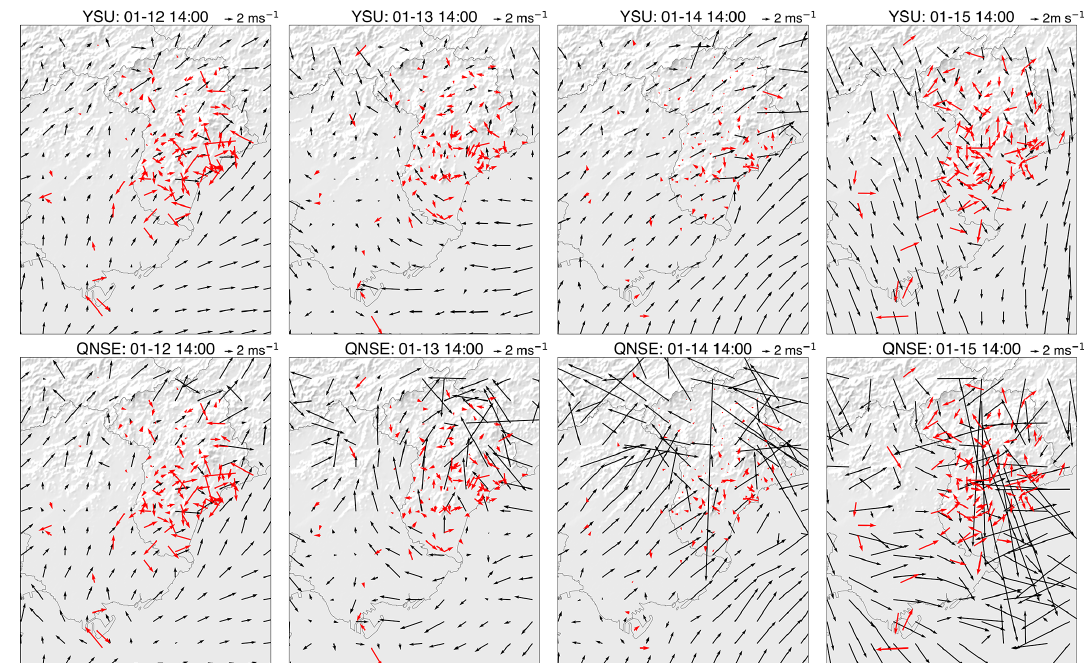
Figure 13. Spatial distribution of simulated (black vector) and observed (red vector) winds at 14:00LT during the study period from simula- tions with the YSU and QNSE schemes; the shading indicates the elevation, and the height of the wind is 10m.